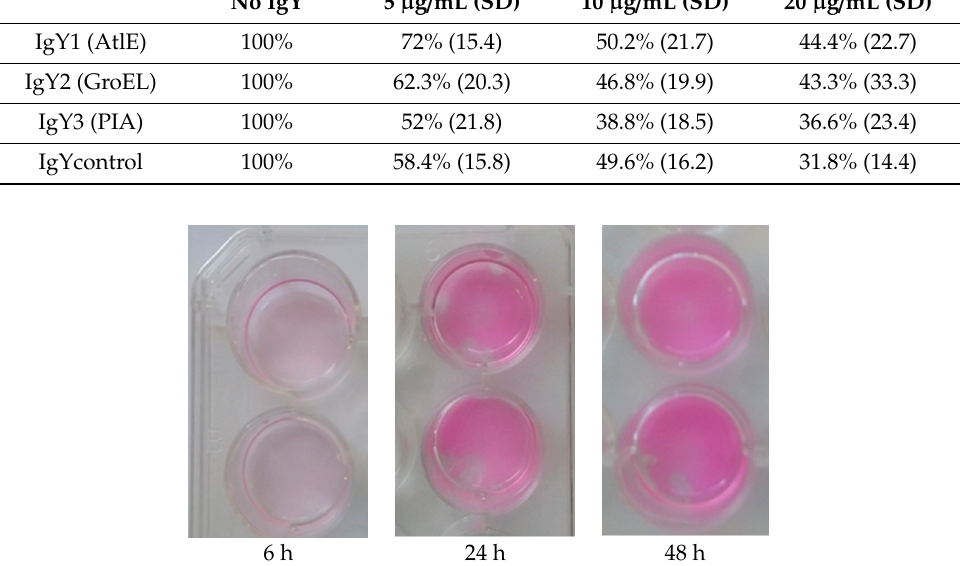
Table 1. Inhibition of biofilm formation in % by IgY1–3 and IgYcontrol. Mean values of 5 experiments and standard deviation are shown.